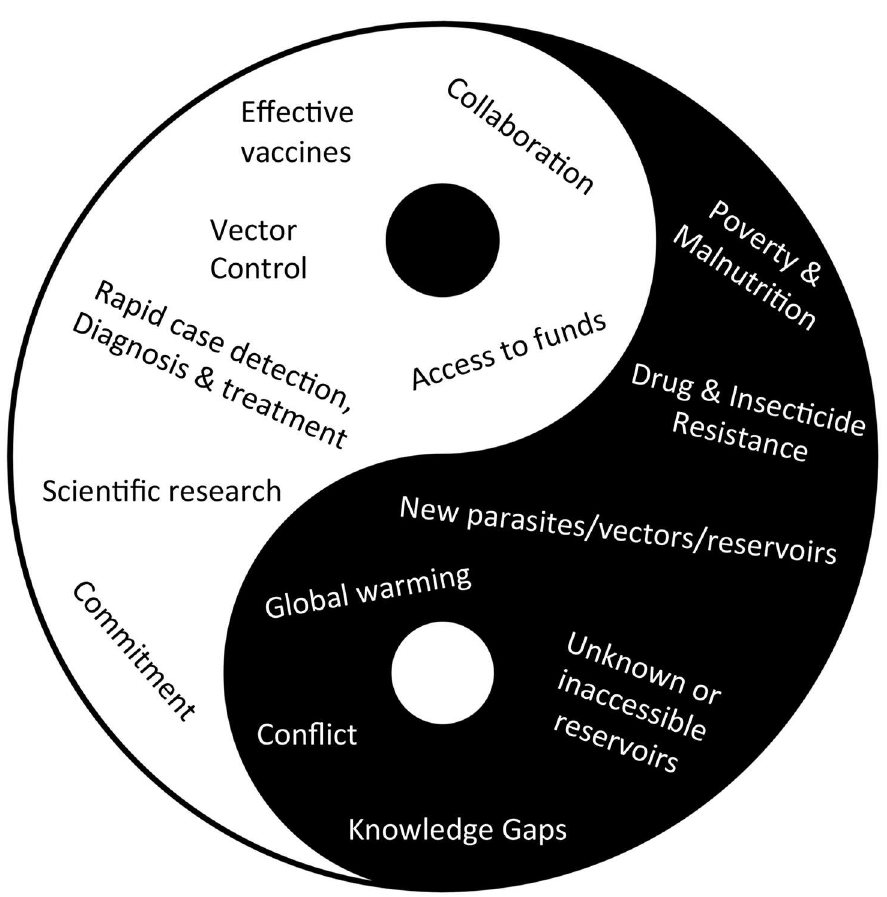
Fig 1. The yin and yang of leishmaniasis control. Disruptivenatural and man-madedisease-promoting elementsare opposedby efforts to control or eliminateleishmaniasis through commitment, collaboration, and continuedresearch towards better vaccines, drugs and